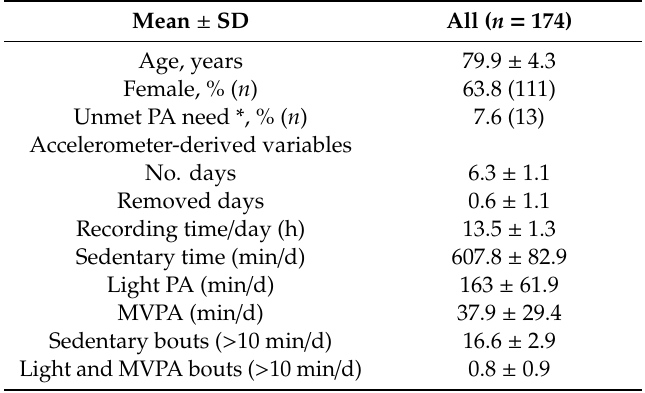
Table 1. Participant characteristics, physical activity (PA), and sedentary